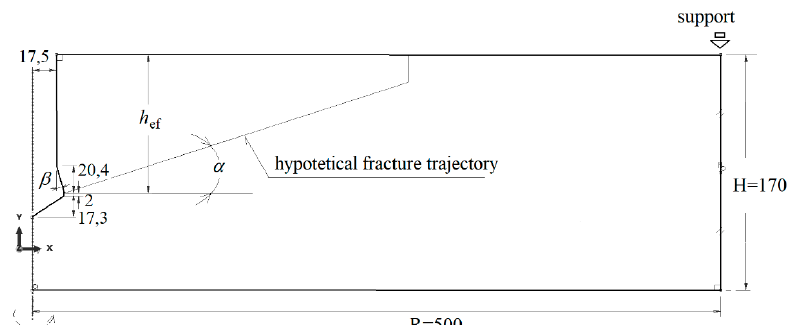
Figure 2. Axisymmetric model of anchor interaction with rock: β — anchor head angle, α —angle of the potential failure cone.